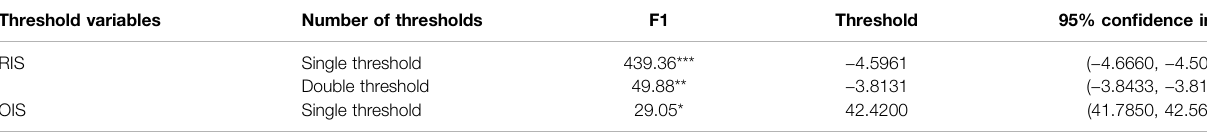
TABLE 6 | Threshold variables test and threshold value estimation.